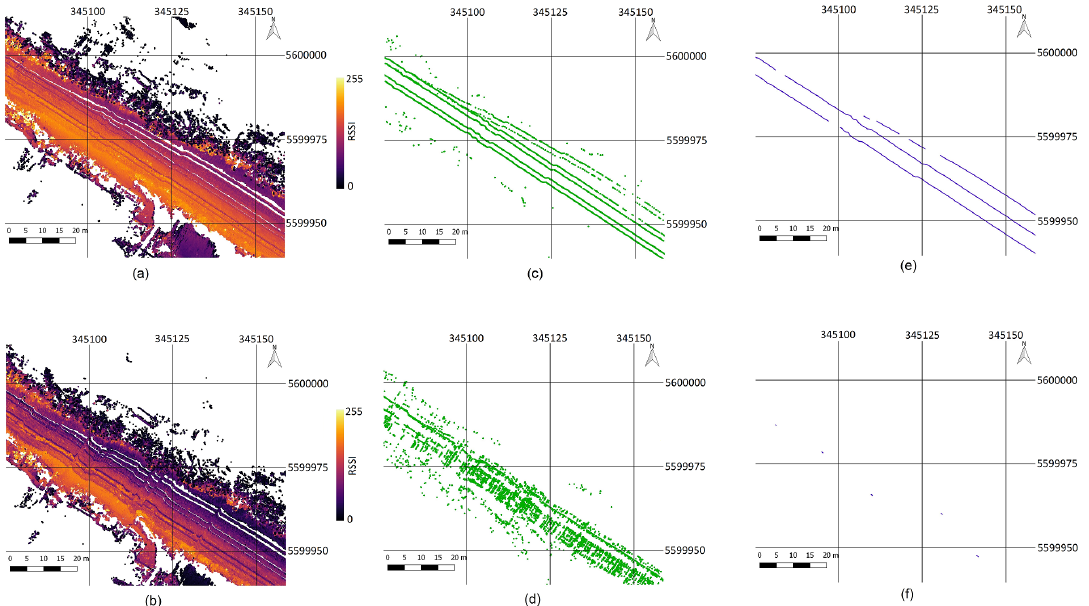
Figure 7. Illustration of the effect of weather on center line mapping process. ( a , b ): Georeferenced point cloud. ( c , d ): Points identified as rails in Step 1 of the algorithm. ( e , f ): Centerlines extracted from the point